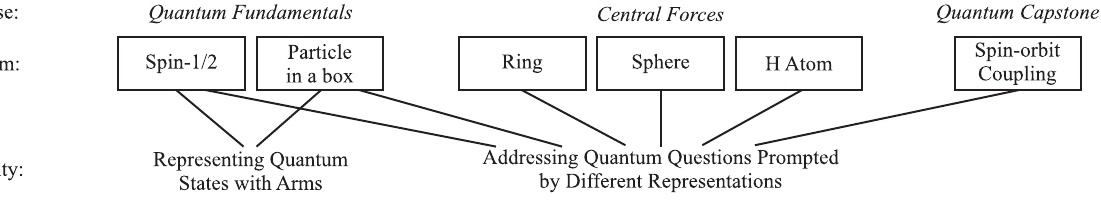
FIG. 1. The sequence of quantum systems considered across the QM Paradigms , with two example activities and where they occur and recur indicated.